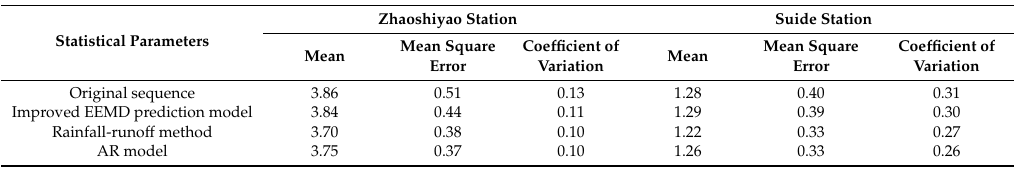
Table 4. Statistical parameters between extended runoff series by different models and observed series at the Zhaoshiyao and Suide